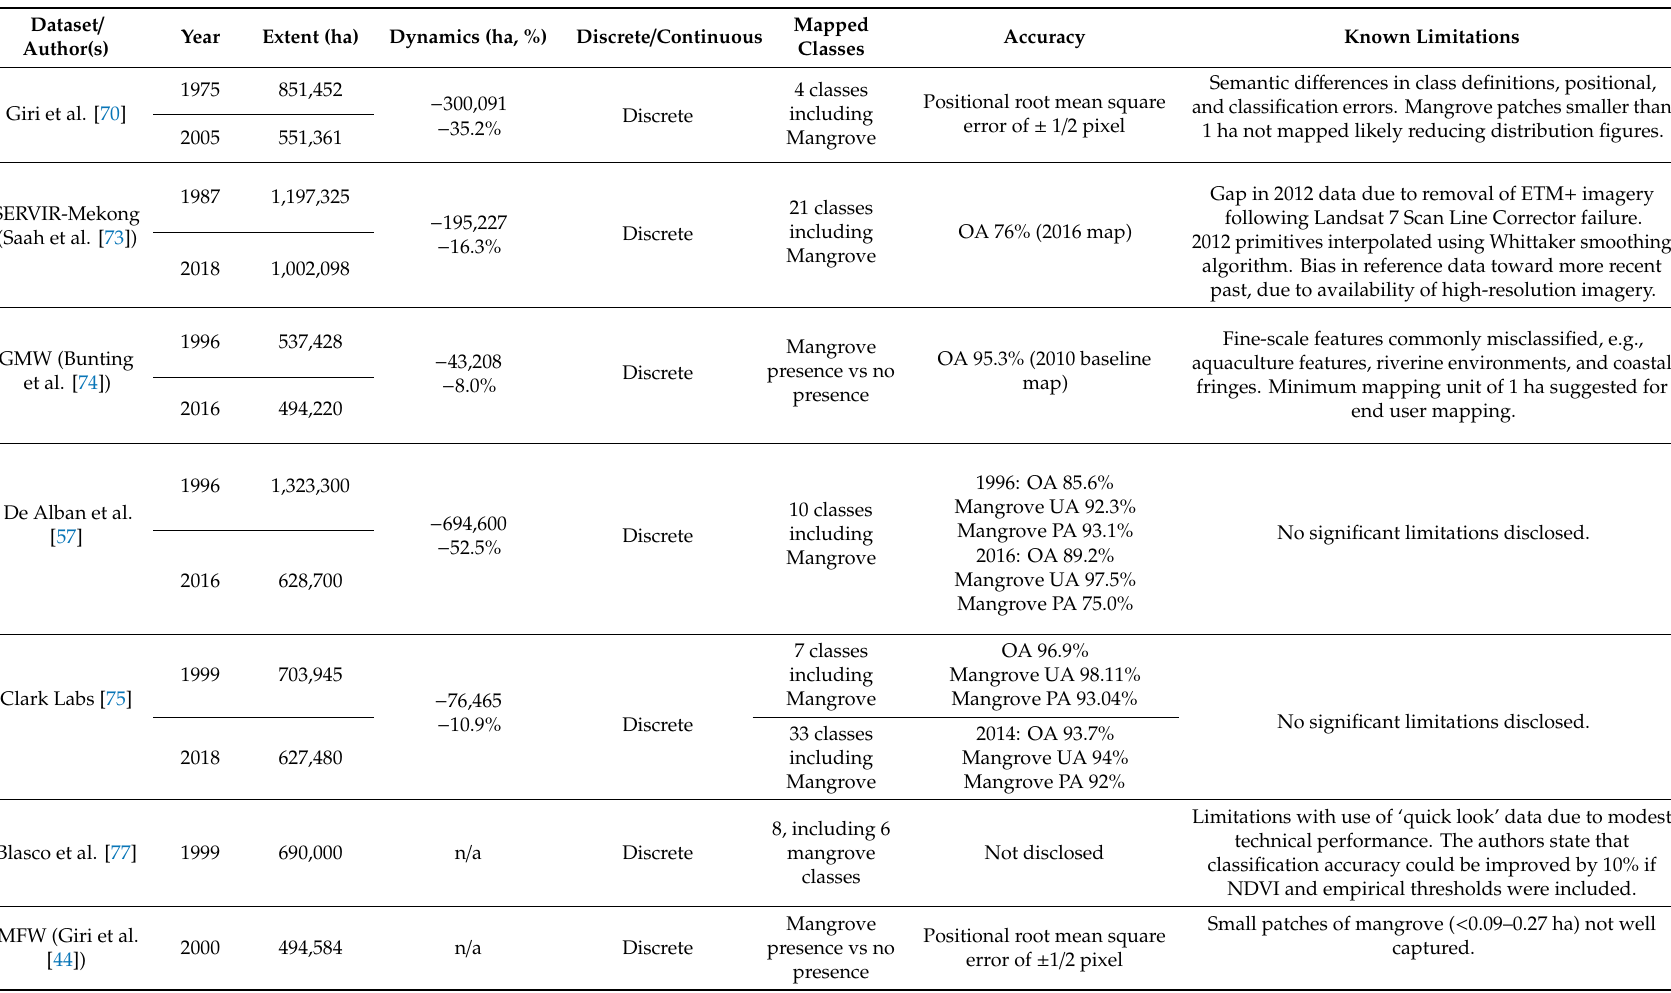
Table 5. Comparison of single- and multi-date datasets based on mapped classes, accuracy, mangrove distribution (ha), dynamics, and known limitations. Accuracy: OA = overall accuracy; UA = user’s accuracy; PA = producer’s